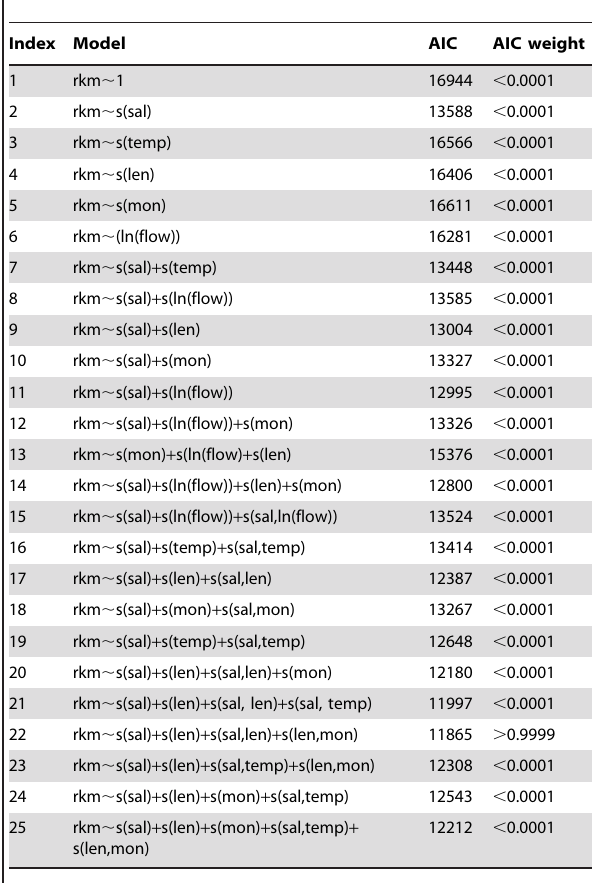
Table 1. Comparison of General Additive Models